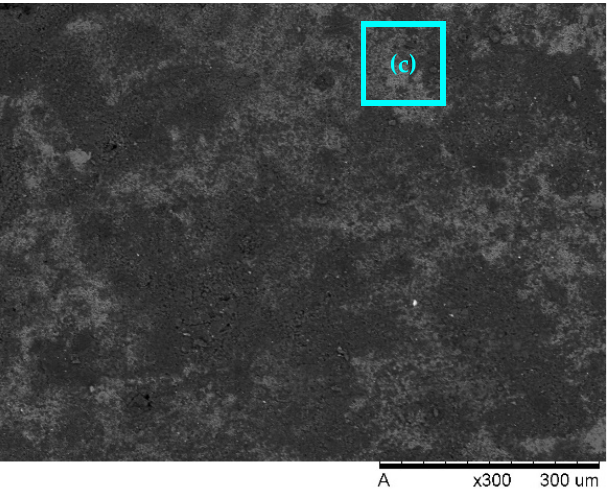
Figure 9. The characterisation of the electrode ( a ) before treatment, ( b ) after the EC process, ( c ) after US-EC.